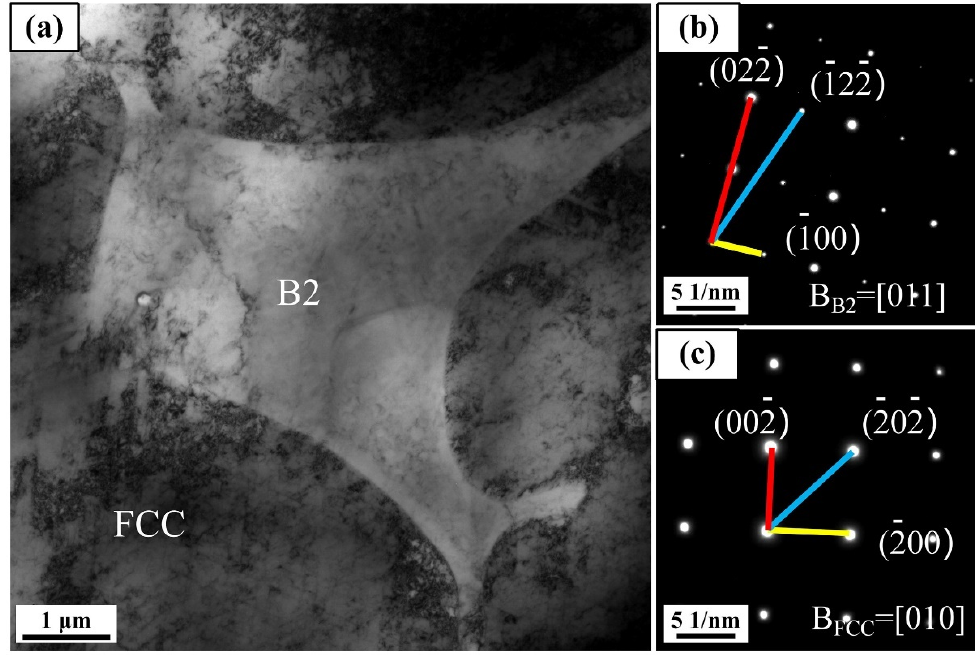
Figure 11. TEM image of Al 0.5 FeCoCrNi HEA manufactured by LMD: ( a ) bright-field TEM image with corresponding SAED pattern; ( b ) SAED pattern of B2 phase; ( c ) SAED pattern of FCC phase.